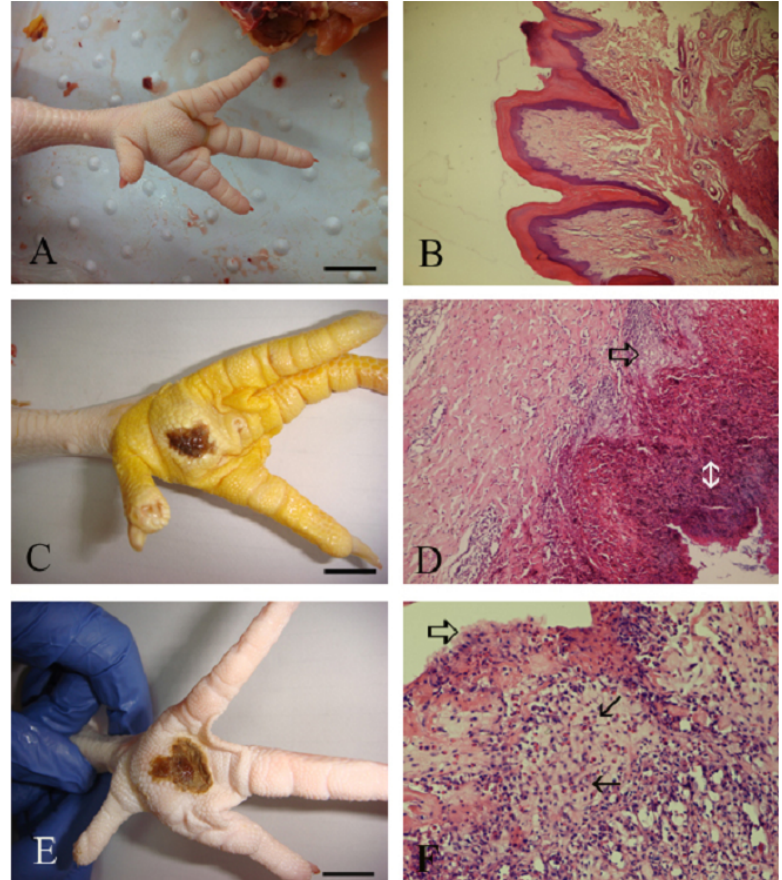
Figure 1. Macroscopic and microscopic features of footpads in healthy and affected animals. Score I: (a) no prominent lesion is visible on the footpad, with normal skin and no discolouration (S1); the microscopical appearance of the skin structure is normal (b) . Bar: 1cm; 100x magnification. Score II: (c) gross view of ulcerative lesion ( < 1cm 2 ) and scab formation in the skin of footpad dermatitis. Bar: 1cm. (d) Histopathological features of affected skin; erosive and ulcerative epidermis (open arrow); degenerative and necrotic epidermal cells in scab (double headed arrow). 200x magnification. Score III: (e) gross view of ulcerative lesion (score SIII) ( > 1cm 2 ) and scab formation with brown discoloration in the skin of footpad dermatitis. Bar: 1cm. (f) Histopathological features of the footpad; ulcerative surface of skin (open arrow); heavy infiltration of the dermis by heterophiles and other monocytic cells (arrows). 200x magnification.